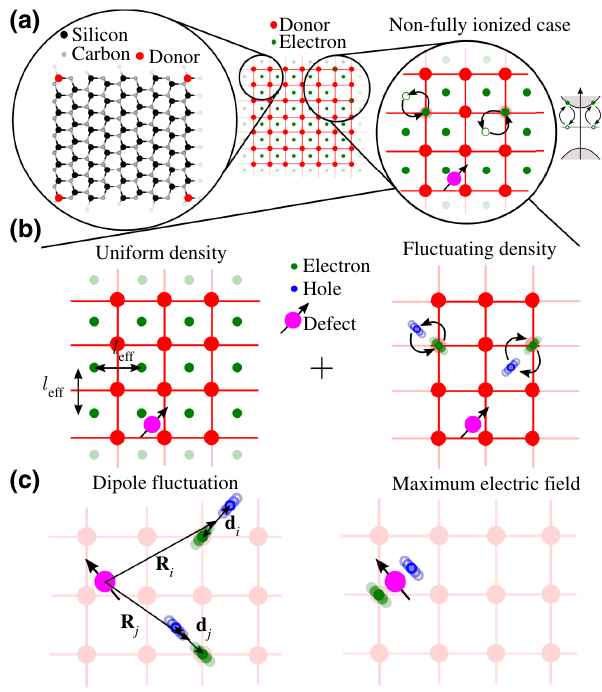
FIG. 4. (a) The 4 H -SiC crystal structure with donors together with the non-fully-ionized case with fluctuation of trapped charges. (b) The total electronic density is understood as being the sum of a uniform density and a fluctuating density of electron-hole dipole pairs. (c) We model the electron-hole pair fluctuating density though the dipole approximation, where the case of maximum fluctuating electric field is